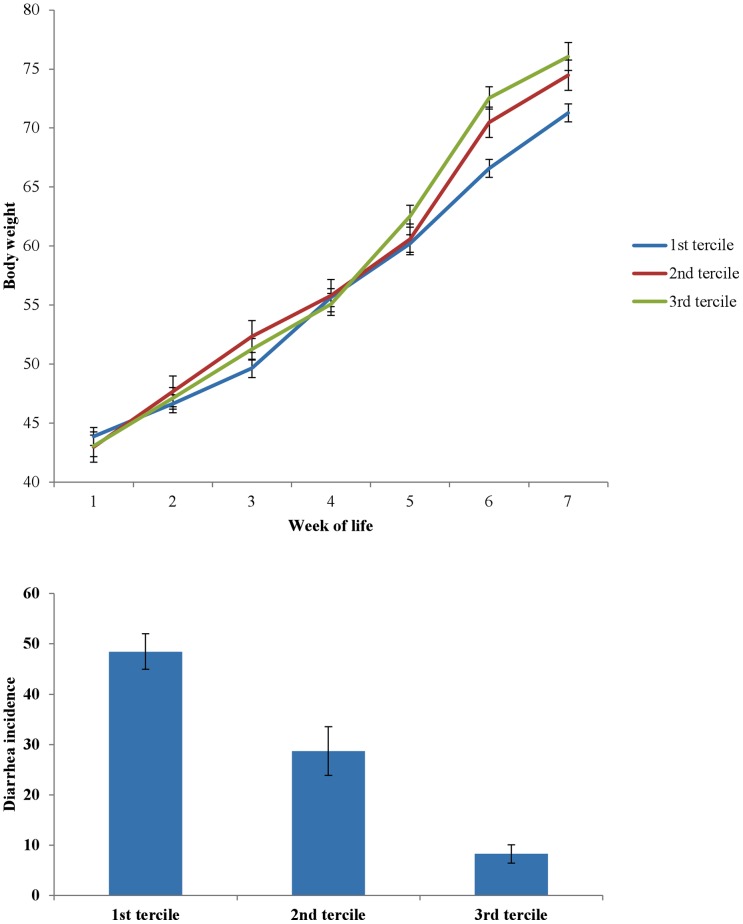
Adjusted means of body weight by week of life as well as adjusted means of diarrhea incidence for different Faecalibacterium spp. terciles. 30, 10 and 21 calves belonged to the first (lower Faecalibacterium spp. prevalence), second and third (higher Faecalibacterium spp. prevalence) tercile respectively.